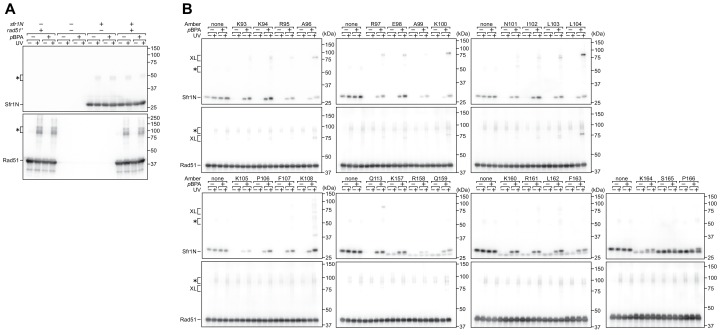
Nonspecific and specific crosslinking of Sfr1N to Rad51.(A) The extent of non-specific crosslinking was assessed by individual and co-expression of Sfr1N and Rad51 in E. coli. (B) Specific crosslinking was assessed by expressing Rad51 with a version of Sfr1N in which a residue of interested was mutated to TAG, which encodes the photoreactive amino acid pBPA in this system.